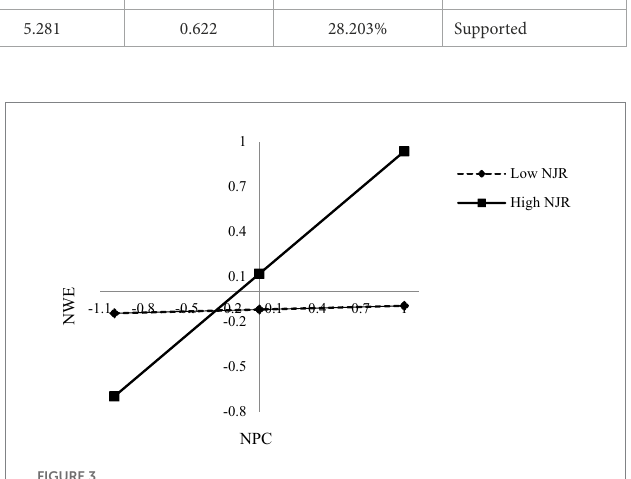
FIGURE 3 The moderating role of nurses’ job